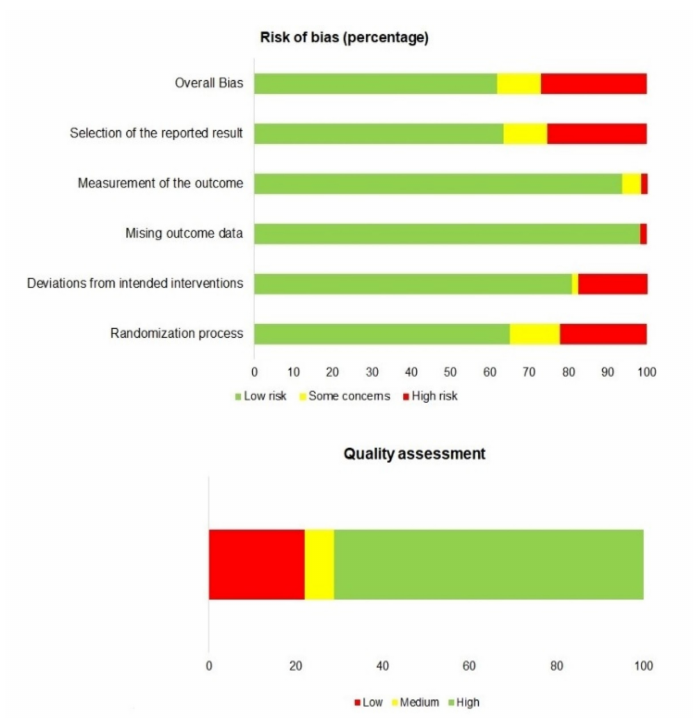
Figure 2. Risk of bias (upper panel) and quality assessment (bottom panel) of the selected genetic studies, as a percentage of the total.